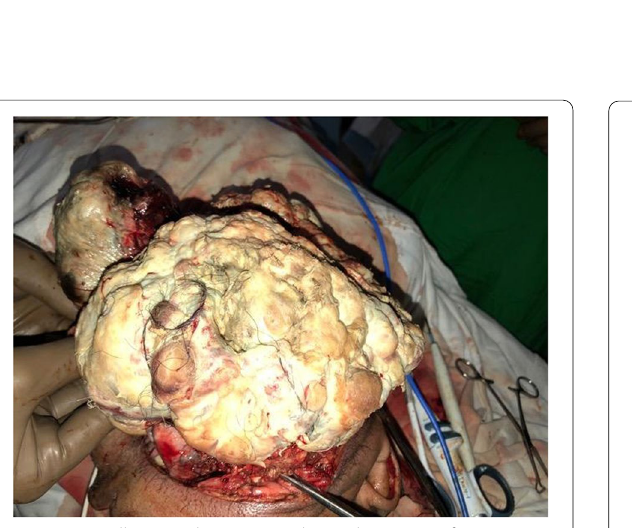
Fig. 3 Closure of the defect in right hemiface of 15 cm